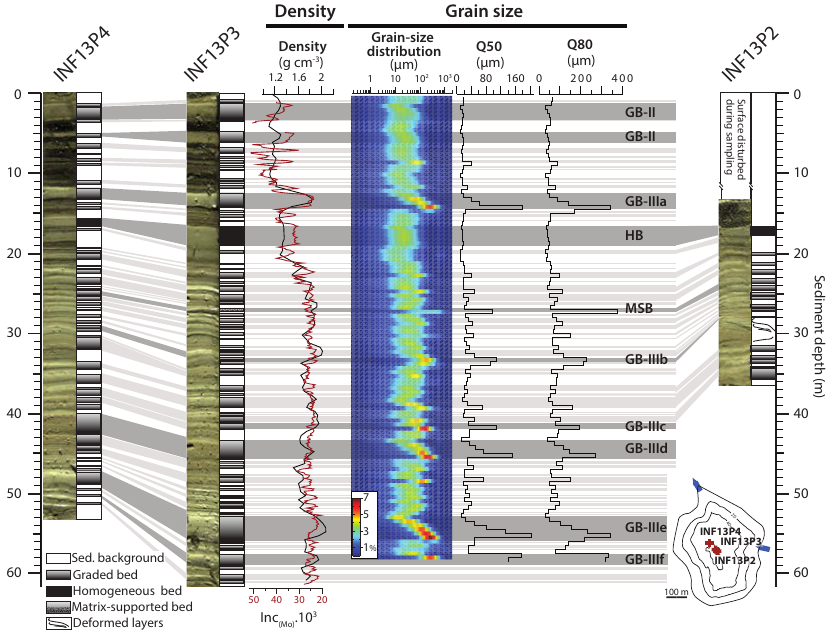
Figure 3. Lithological descriptions of cores and stratigraphic correlations based on sedimentary facies. Variability in grain-size distribution is shown for the core INF13P3. The density measurements performed by gamma-ray attenuation are shown close to Mo inc , used as a high- resolution density proxy. The horizontal bars highlights the stratigraphical correlation between cores with a distinction between two probable triggers of deposits (light versus dark grey) as discussed in Sect. 5.1 and